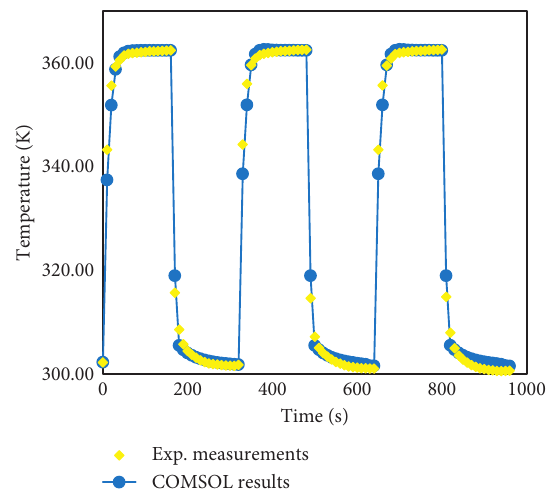
Figure 3: Variation of the average temperature in the adsorbent bed with time.